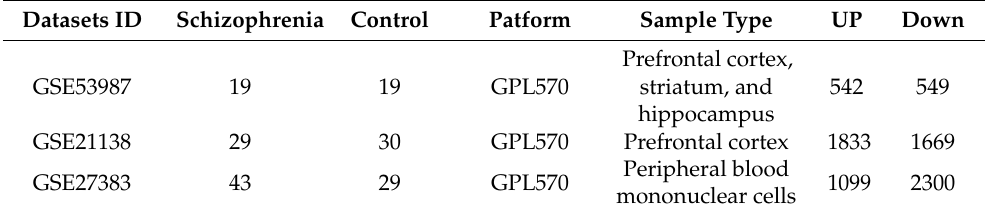
Table 1. Statistical data for three GEO datasets (GSE53987, GSE21138, and